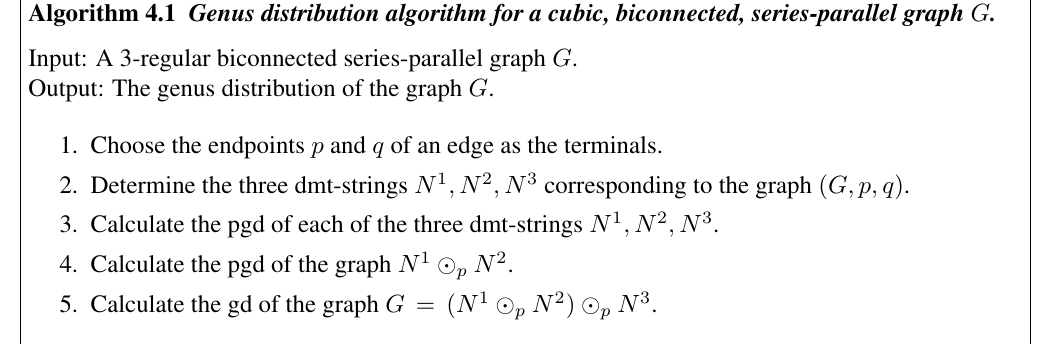
Algorithm 4.1 Genus distribution algorithm for a cubic, biconnected, series-parallel graph G .